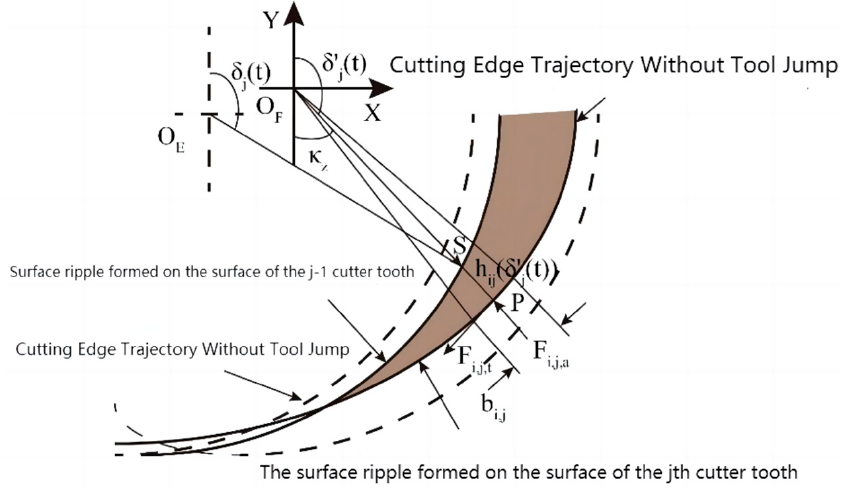
Figure 6. Trochoid trajectory of the ( j − 1)th and j th tooth in the end milling process.